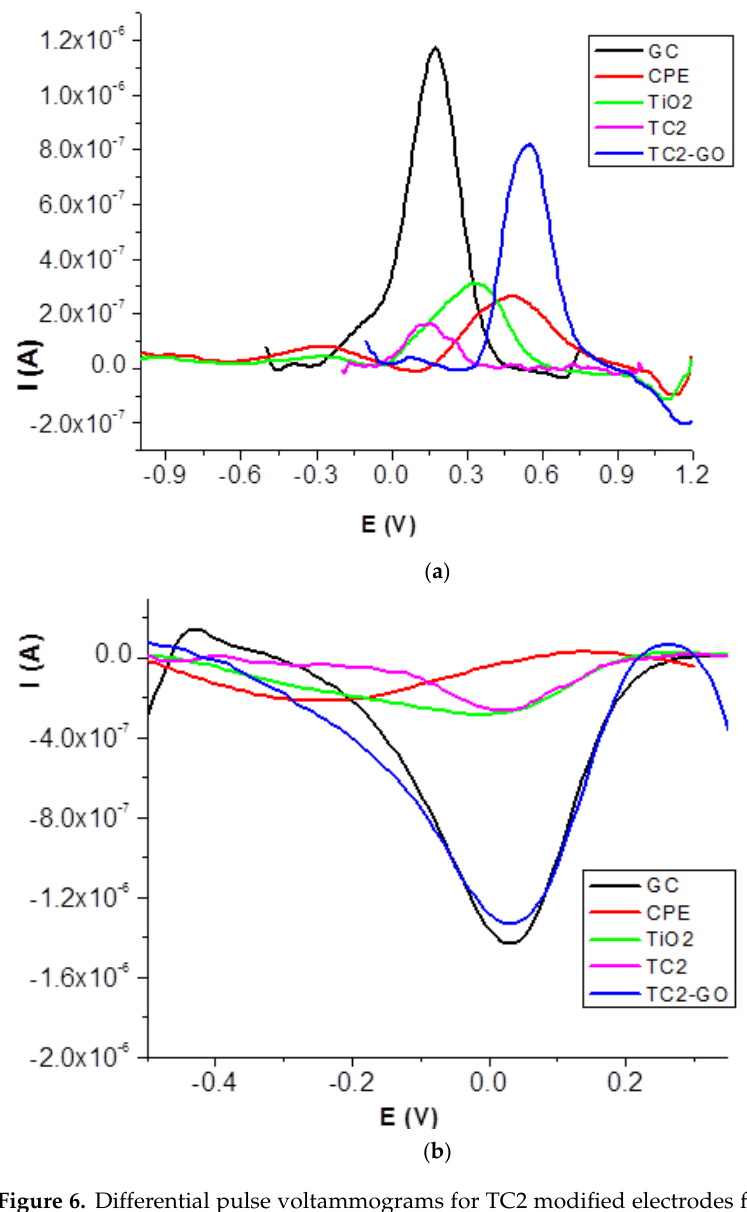
Figure 6. Differential pulse voltammograms for TC2 modified electrodes for the redox process of 1.0 mM K 3 [Fe(CN) 6 ] in 0.1 M KCl solution (with step potential 10 mV and modulation amplitude 25 mV): ( a ) anodic and ( b ) cathodic waves.